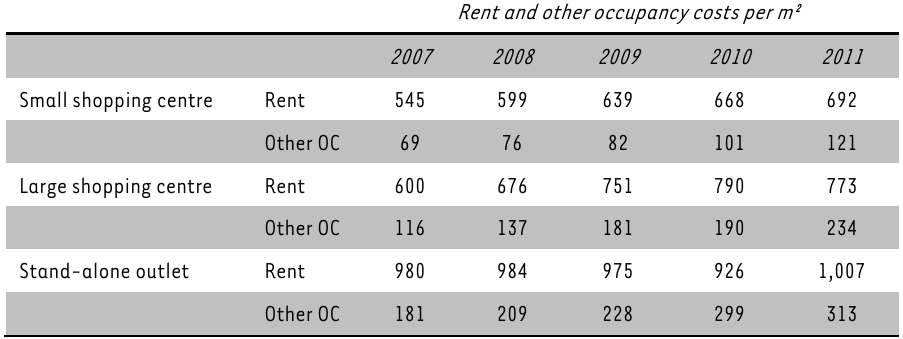
TABLE 7: Summary of rent and other occupancy costs per m² per store by retail format Rent and other occupancy costs per m²